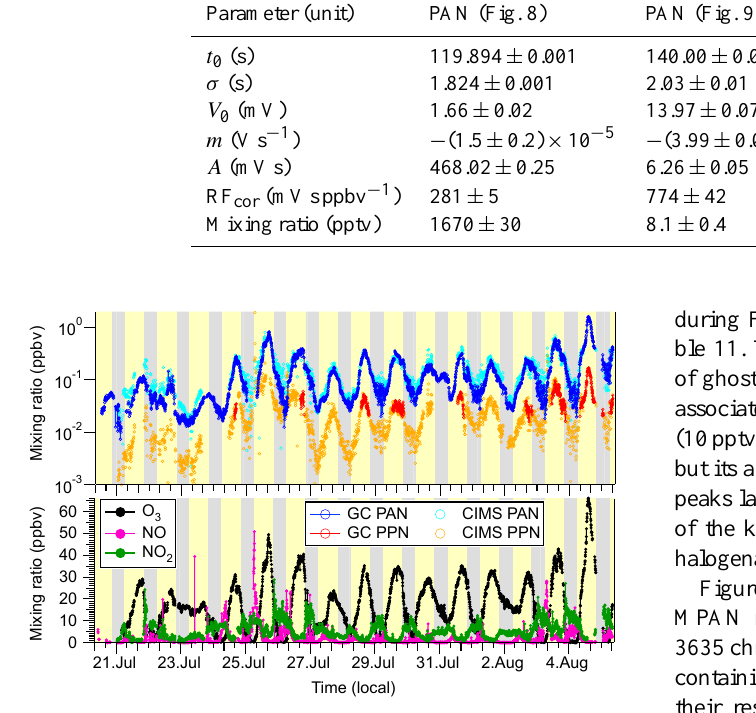
Figure 10. Time series of PAN and PPN (top) and the NO, NO 2 , and O 3 mixing ratios (bottom) observed in